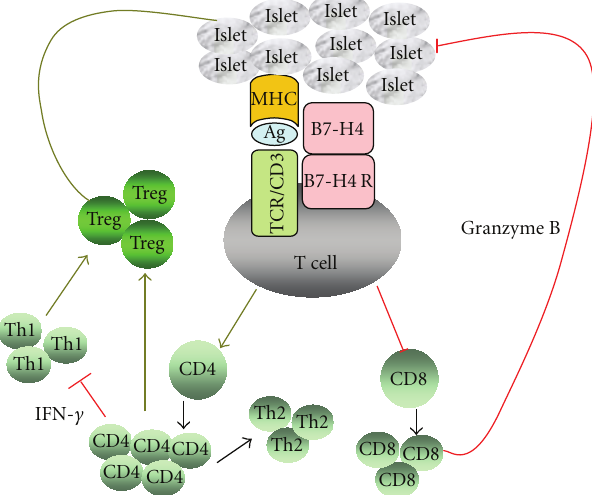
Figure 3: The mechanism of B7-H4 action in islet transplantation. Interaction between B7-H4 and an unknown receptor on activated T cells leads to a series of intracellular signalling cascades that result in improved allograft survival. B7-H4 protects allograft rejection through deletional and nondeletional mechanisms. It can limit cytotoxic CD8 + proliferation and transcription of granzyme B. It also reduces the Th1 response which may facilitate generation of suppressive Foxp3 + Tregs. The combination of controlling activated T-cell proliferation and promoting regulatory T-cell subsets results in enhanced allograft survival and induction of donor-specific